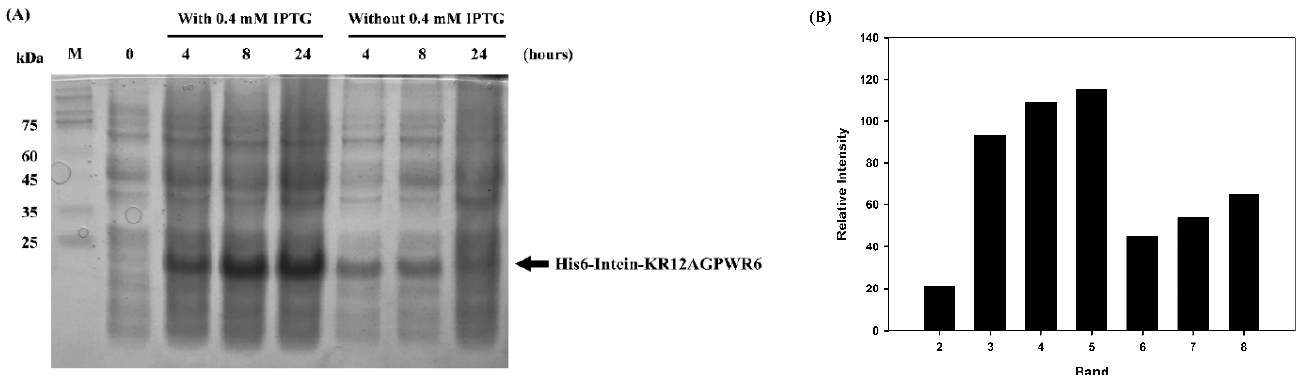
Figure 2. SDS-PAGE analysis of recombinant His6-Intein-KR12AGPWR6 in E. coli BL21. ( A ) SDS-PAGE of recombinant His6-Intein-KR12AGPWR6 expressed in E. coli BL21 with or without 0.4 mM IPTG at 20 °C for 4, 8, 24 h. Lane 1: protein molecular weight markers (kDa). Lane 2: before induction. Lanes 3–5: with IPTG induction at 20 °C for 4, 8, 24 h. Lanes 6–8: without IPTG induction at 20 °C for 4, 8, 24 h. ( B ) Relative intensities of the His6-Intein-KR12AGPWR6 bands. Proteins were visualized using Coomassie blue staining.